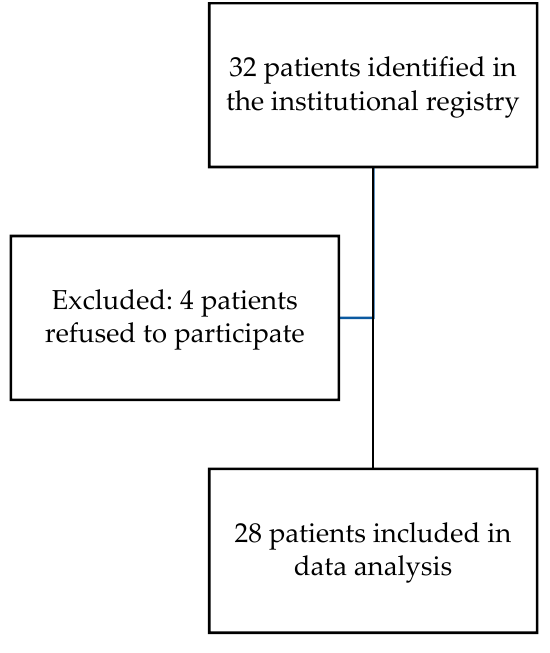
Figure 1. Patient inclusion/exclusion flowchart.